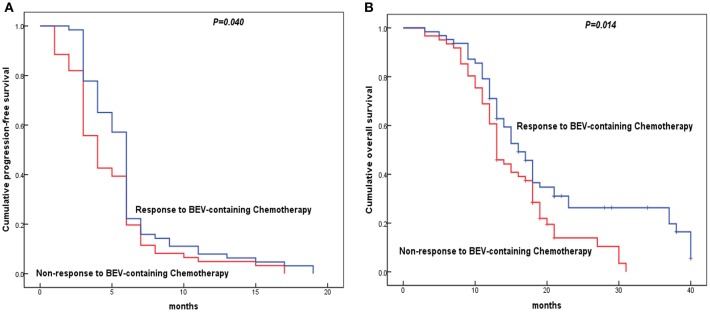
Kaplan-Meier analysis for the disease-free survival and overall survival of epithelial ovarian cancer (EOC) patients with cisplatin resistant recurrence according to patients' response to Bevacizumab-containing chemotherapy. The survival curves were analyzed by the log rank test. (A) Cisplatin resistant EOC patients with non-response to Bevacizumab-containing chemotherapy showed shorter progress-free survival than those with response to Bevacizumab; (B) Cisplatin resistant EOC patients with non-response to Bevacizumab-containing chemotherapy showed shorter overall survival than those with response to Bevacizumab.